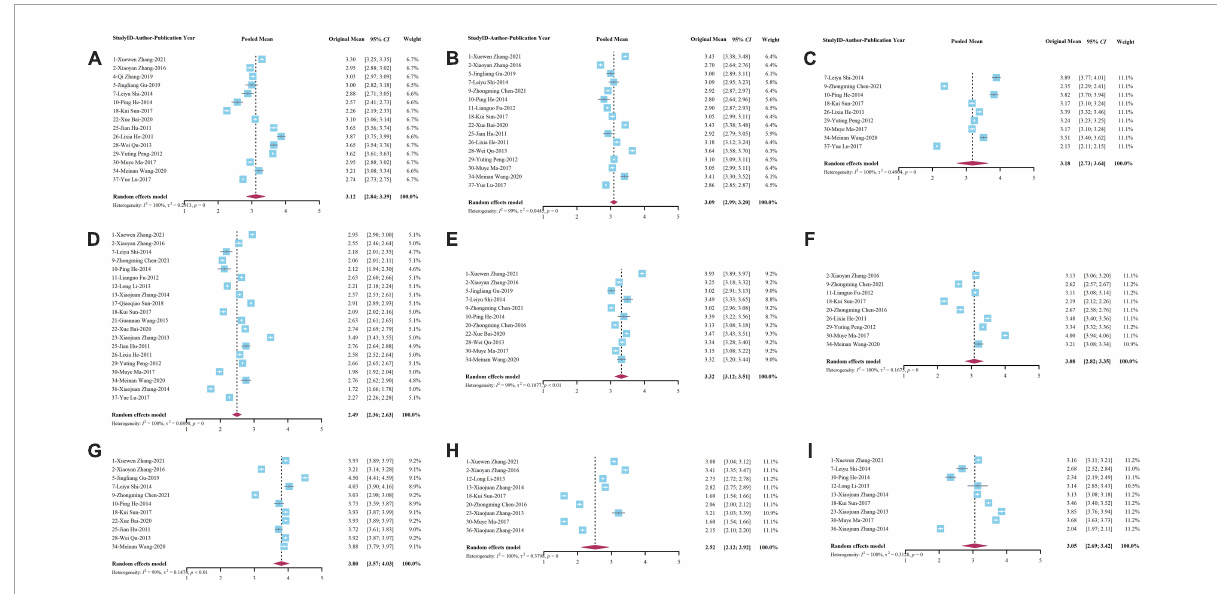
FIGURE4 Forest plot of meta-analysis for each theme of village doctors’ job satisfaction. (A) Career development; (B) infrastructure; (C) respect; (D) financial rewards; (E) governance; (F) work value; (G) interpersonal relationship; (H) job security; and (I) work stress.